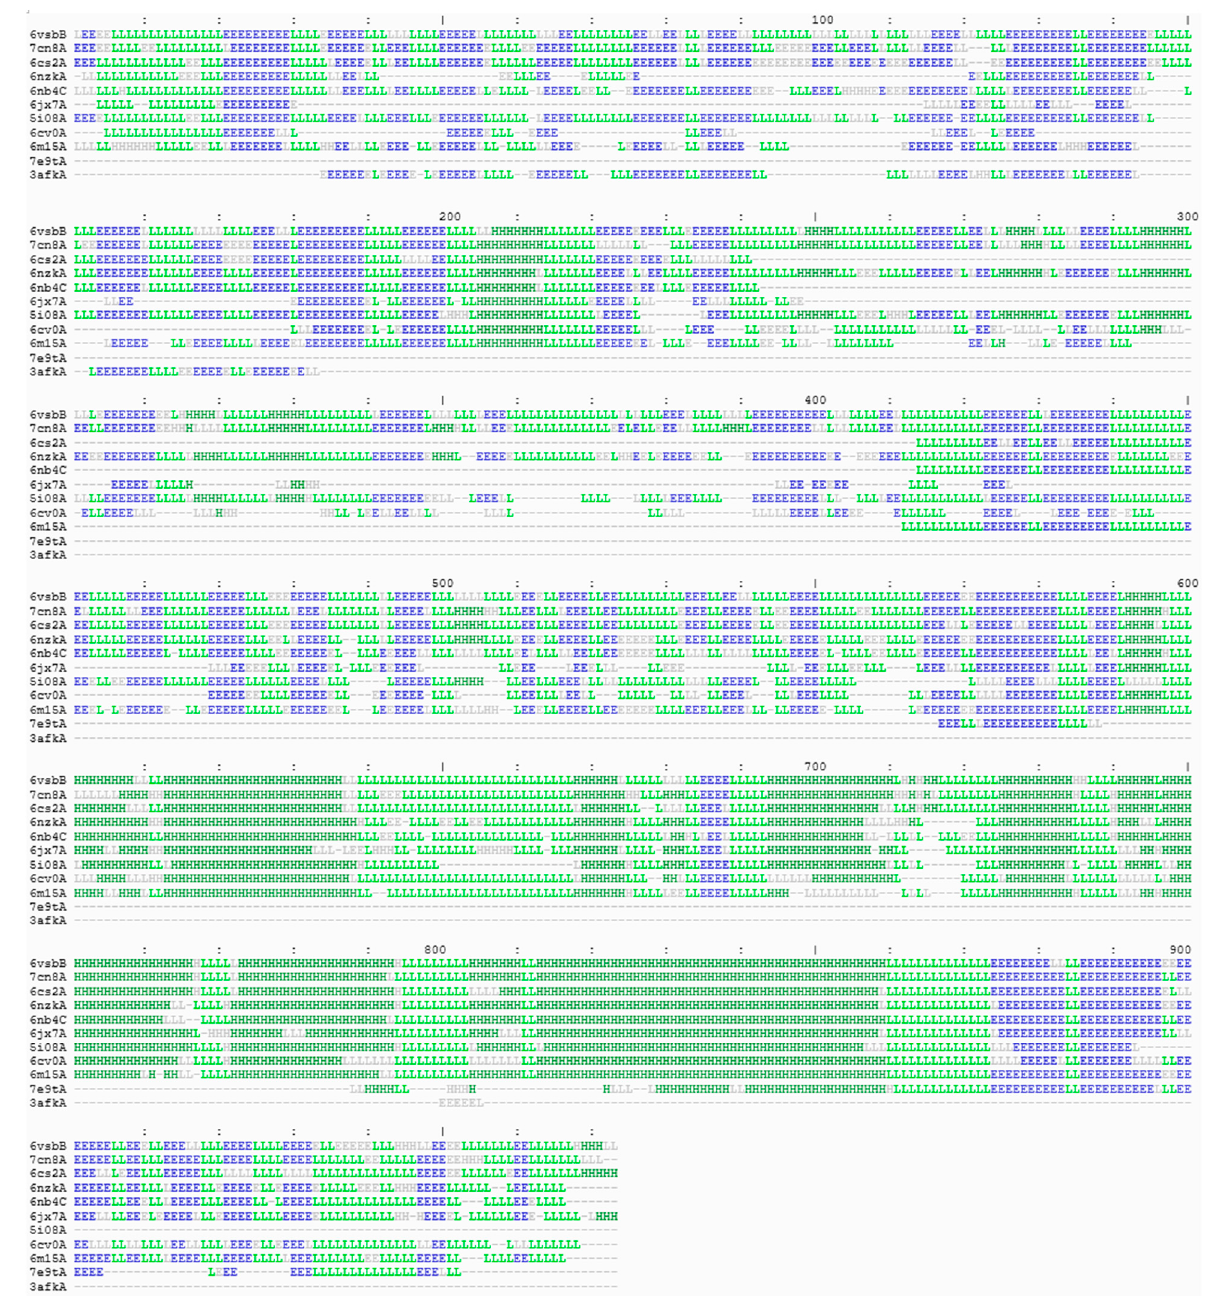
Figure 2. Structural alignment of AAs in 10 protein structures against the query structure. The most frequent AA type in each column is colored. For example, purple residues (S, T, N and Q) are un- charged, brown residues (R and K) are polar positively charged, blue residues (D and E) are polar negatively charged, dark green residues (F, Y, W and H) are non-polar except histidine (positive) but they are aromatic, light green residues (A, V, I and L) are non-polar residues and yellow residue (C) is a special case. The uppercase letters that are bold show conserved structurally equivalent positions with the query structure and non-color regions are variable regions.